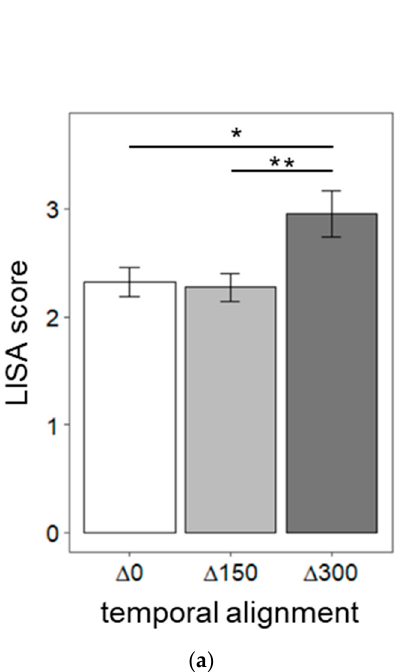
Figure 4. Mean Linear Speed-Accuracy Scores (LISAS) of observers’ congruency responses. LISAS are a compositive score of reaction time and accuracy. In this measurement, reaction times are weighted by the proportion of errors. Thus, lower LISAS indicate higher task performance. ( a ) LISAS for the temporal alignment conditions: occlusion duration and reaction frame matched ( Δ 0), 150 ms deviations ( Δ 150), or 300 ms deviations ( Δ 300). ( b ) Mean Linear Speed-Accuracy Scores (LISAS) of observers’ congruency responses at all combinations of occlusion duration (700, 850, 1000 ms) and reaction frame (700, 850, 1000 ms). Error bars are +/ − standard error of the mean; n.s. indicates a non-significant comparison; * indicates a comparison with p < 0.05; ** indicates a comparison with p < 0.01.